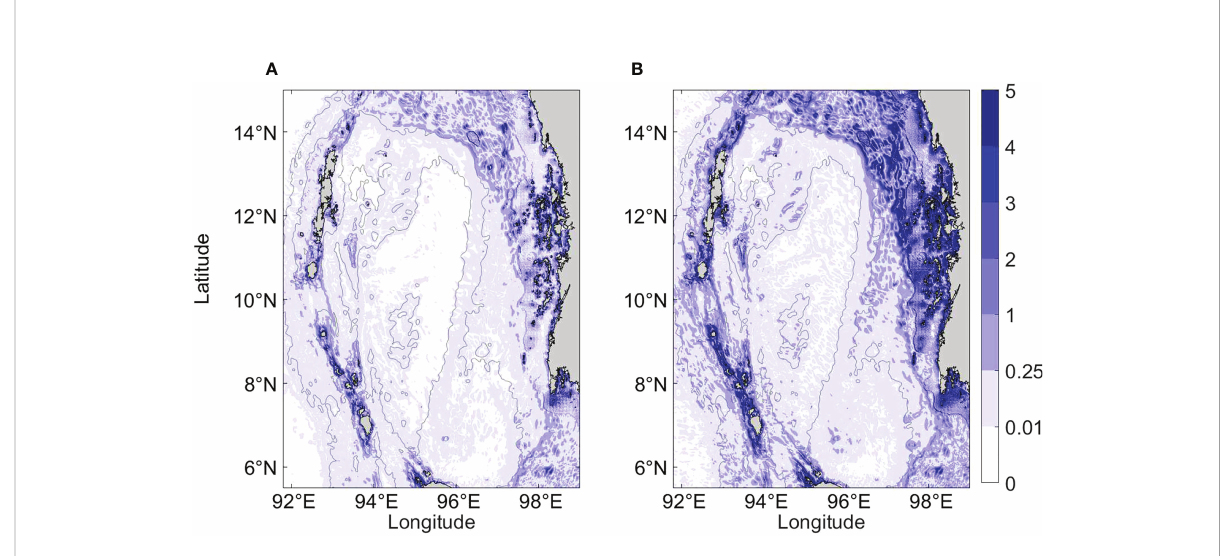
FIGURE 11 Maximum absolute value of depth-integrated internal tide generating body force of (A) K1 tidal constituent and (B) M2 tidal constituent in March. Bathymetry contours are spaced at 500 and 2000 m.